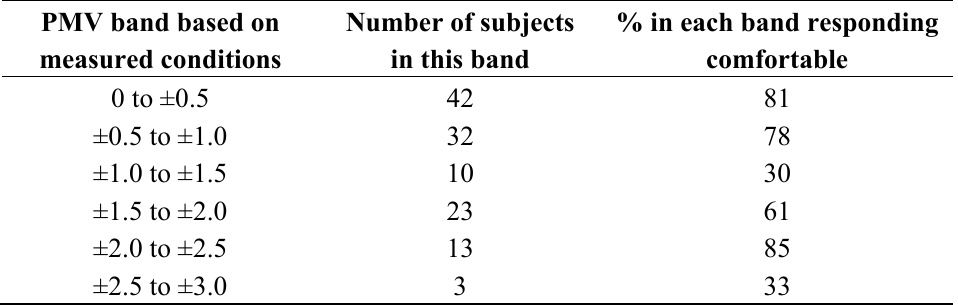
Table 5. Comfortability compared to PMV bands for the circulation zone study (adapted from